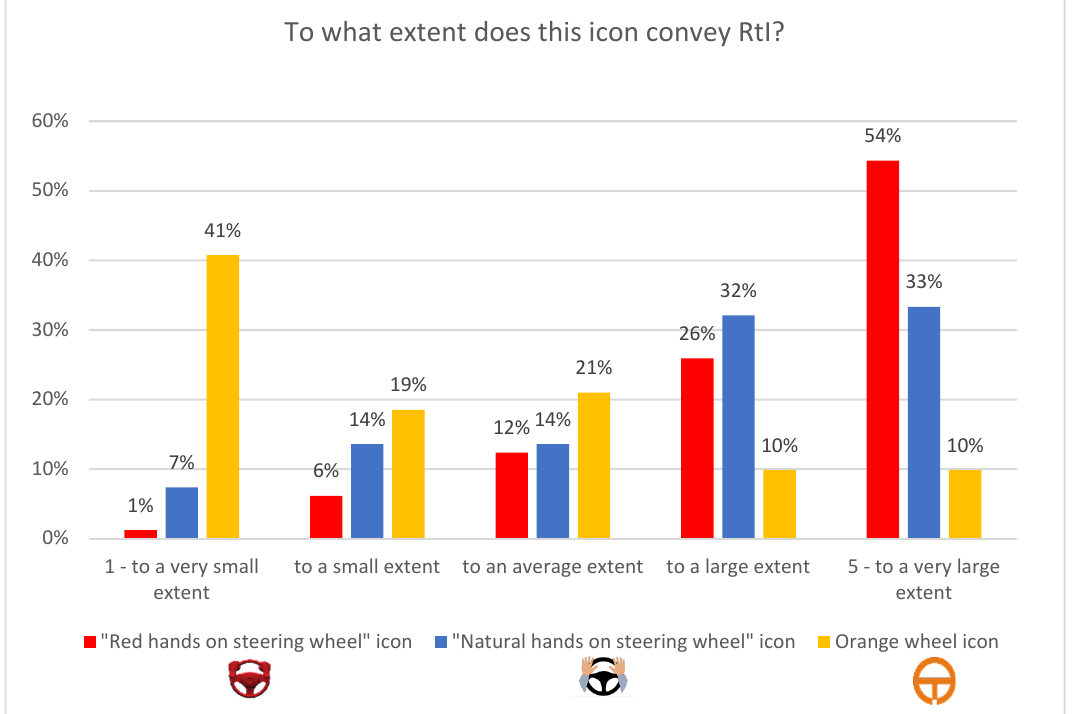
Figure 4. Comparison of the RtI alert level (ITS icons).